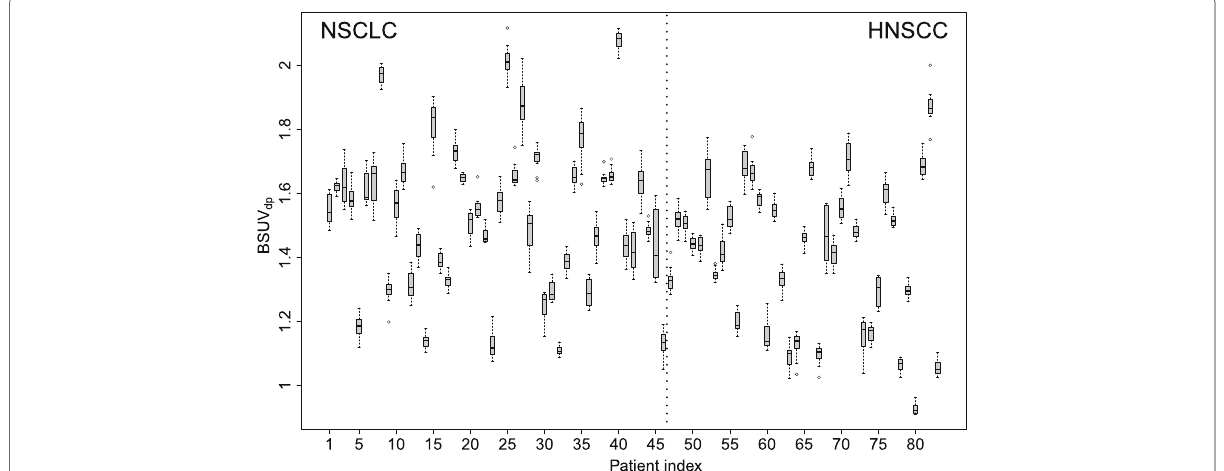
Fig. 2 Boxplot of the observed blood SUV (BSUV dp ), grouped by patient. Note that intersubject variability is much larger than interobserver variability for each